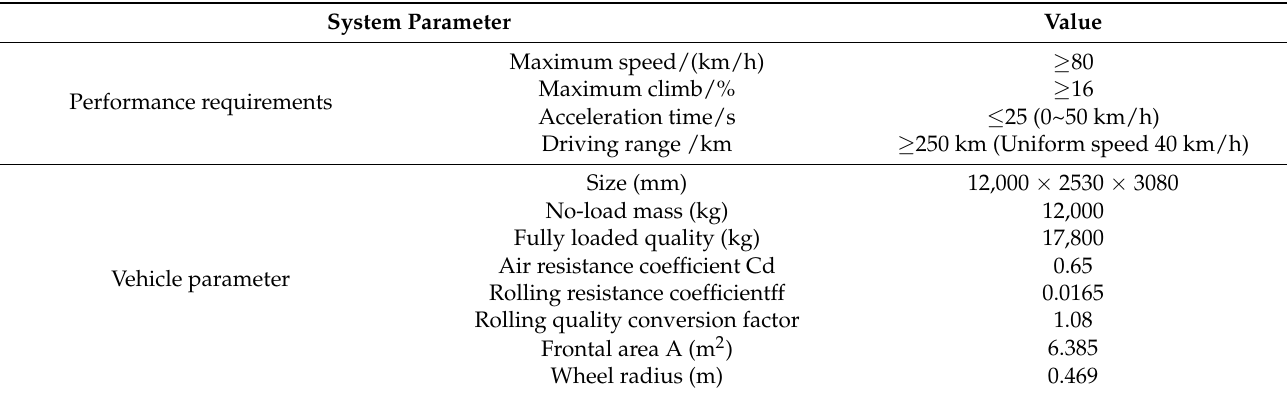
Table 1. Vehicle performance requirements and